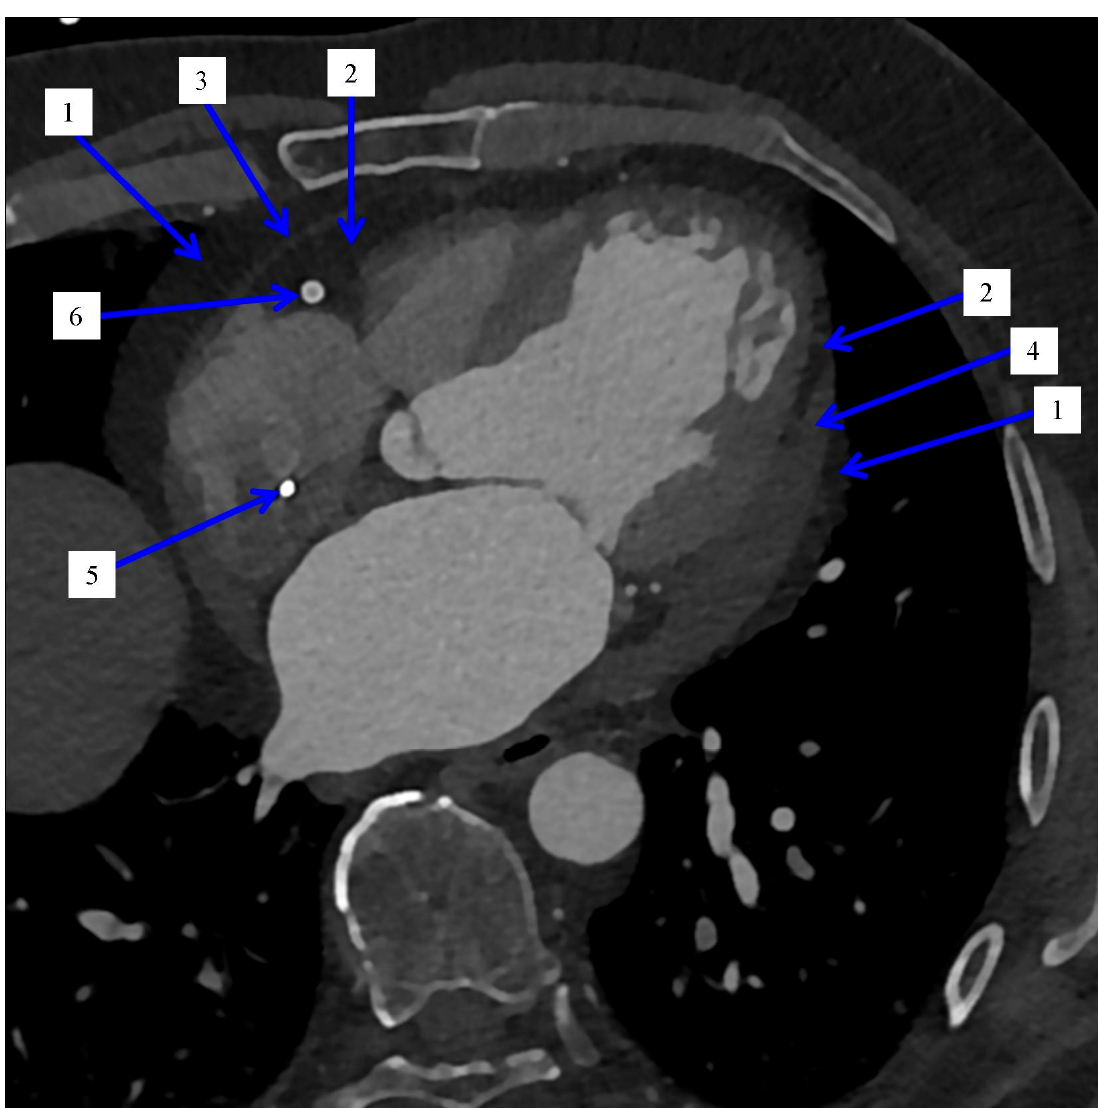
Figure 2. Cardiac computed tomography in a patient after interventional treatment. Multiplanar oblique reconstruction. Blue arrows indicate: 1. Pericardial adipose tissue. 2. Epicardial adipose tissue. 3. Pericardium. 4. Fluid in the pericardium. 5. Cardiac pacemaker electrode in the right atrium. 6. Right coronary artery stent.